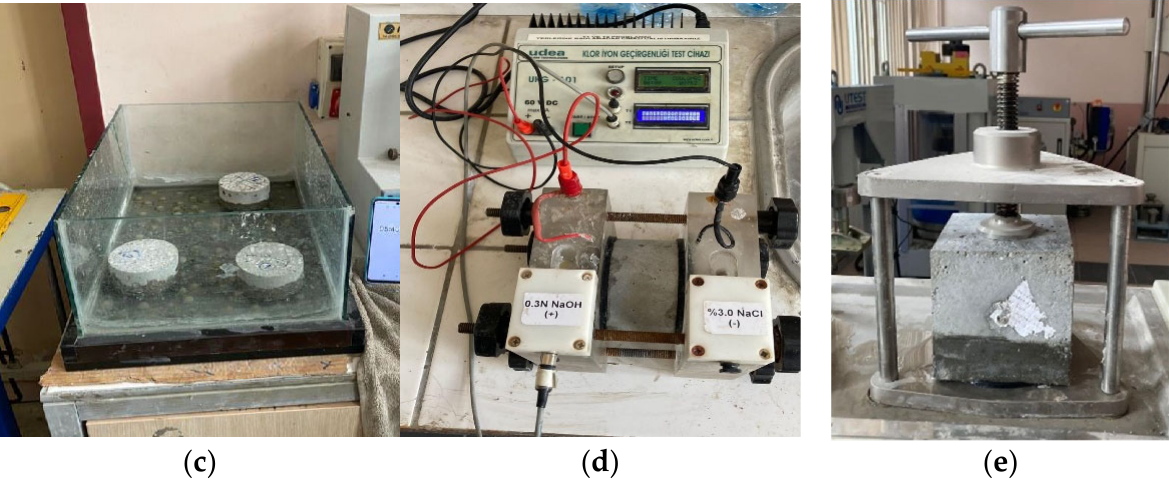
Figure 3. ( a ) Compressive, ( b ) flexural, ( c ) capillary water absorption, ( d ) rapid chloride permeability and ( e ) water penetration test setups.